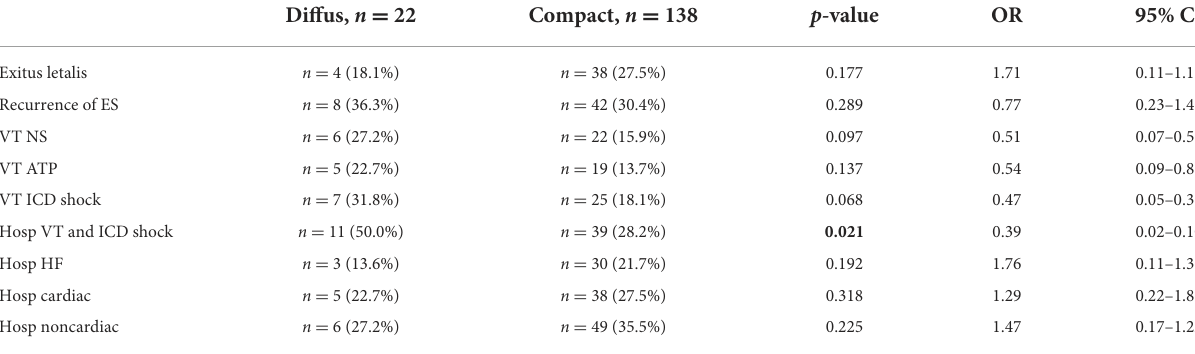
TABLE 7 Analysis between scar localization; diffus vs. any localization compact.